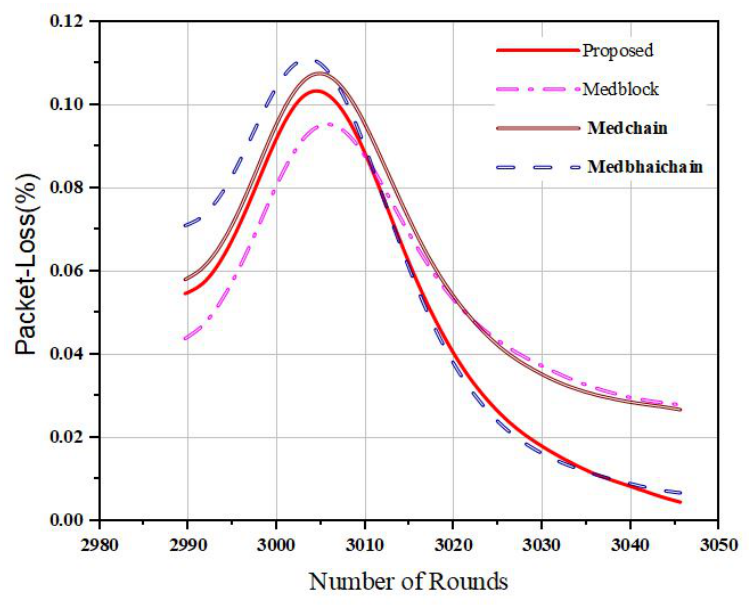
Figure 11. Number of packets sent to the BS versus the number of rounds (0, 2500); comparison with the benchmark models [50,51].